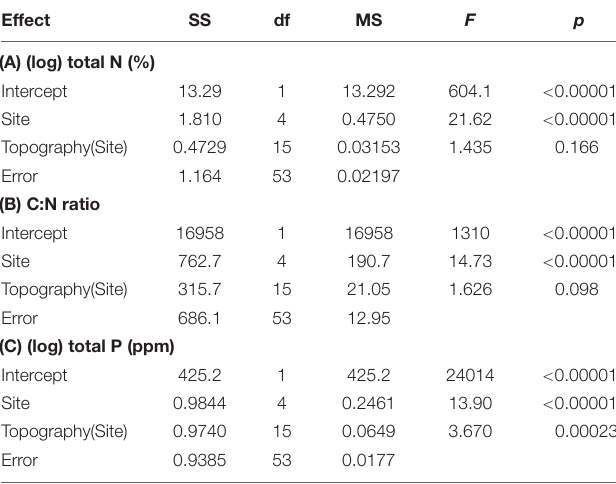
TABLE 2 | Summary of nested ANOVA testing effects of locality and topographic position on topsoil chemistry, across five localities differing widely in macroclimate. Effect